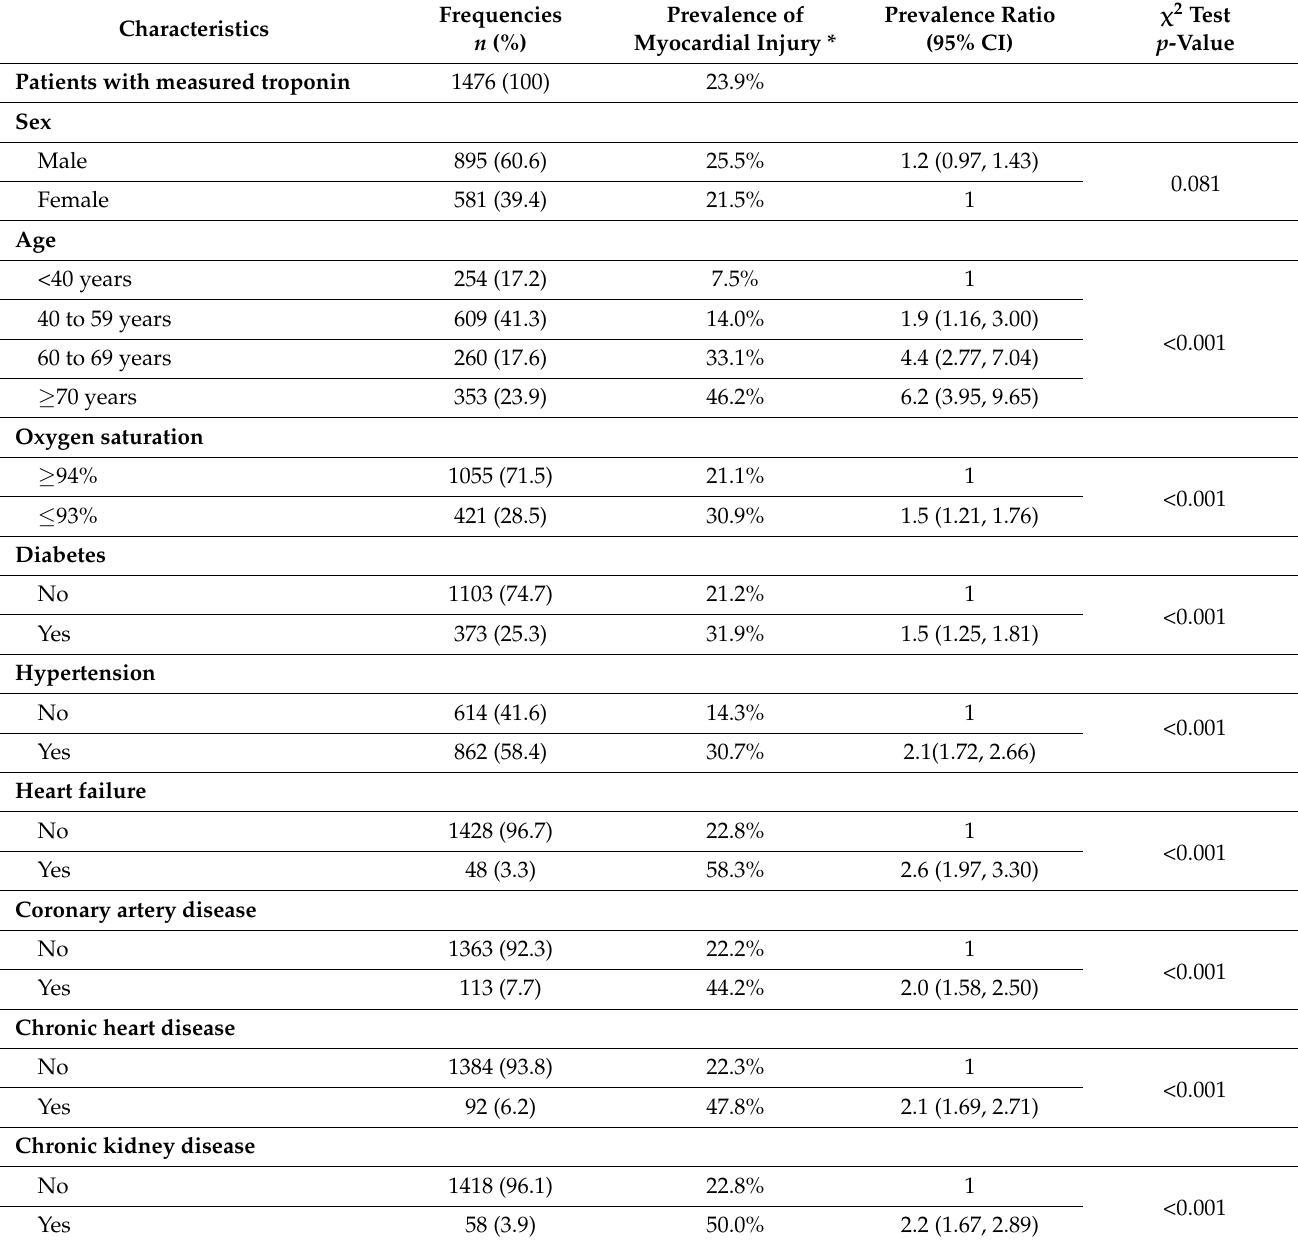
Table 2. Prevalence of myocardial injury * among patients who underwent troponin measurement, according to baseline